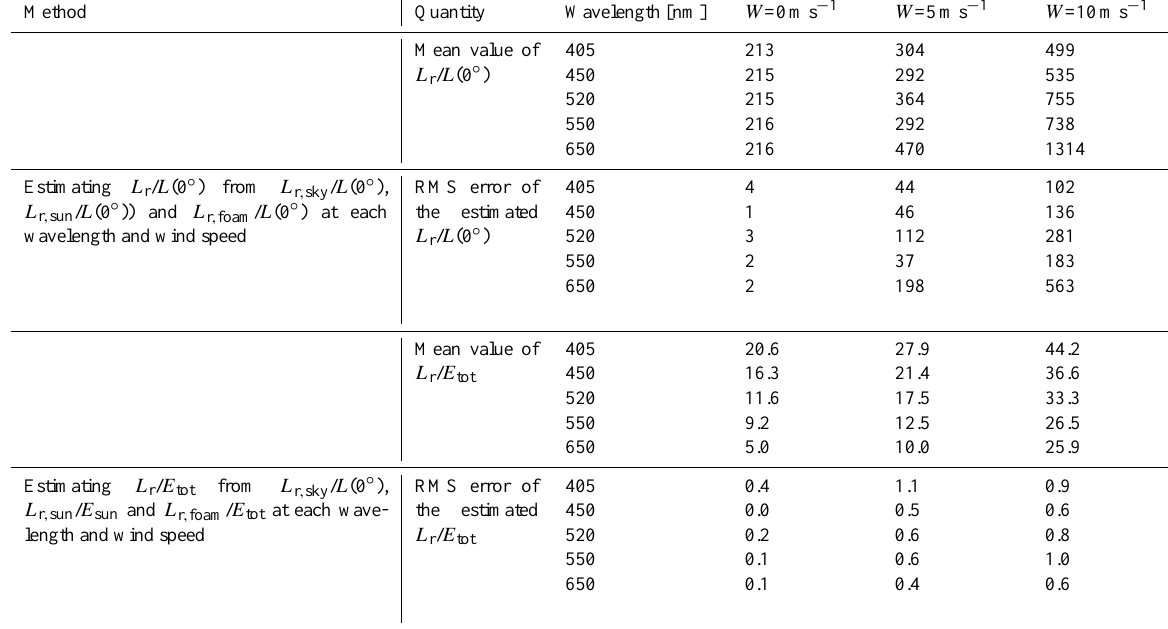
Table 7. Comparison of mean values and RMS errors of L r / L (0 ◦ ) and L r / E tot in units of 10 − 4 by different methods for estimating the reflected